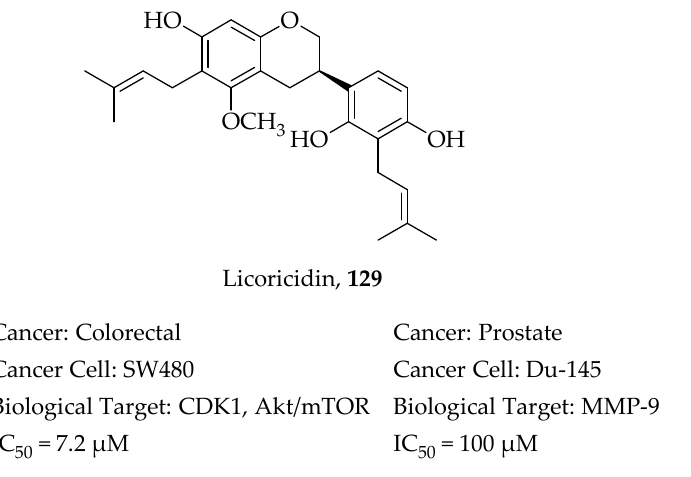
Figure 24. Structure of the prenylated isoflavonoid Licoricidin with a summary of its biological activity towards selected cancer targets.